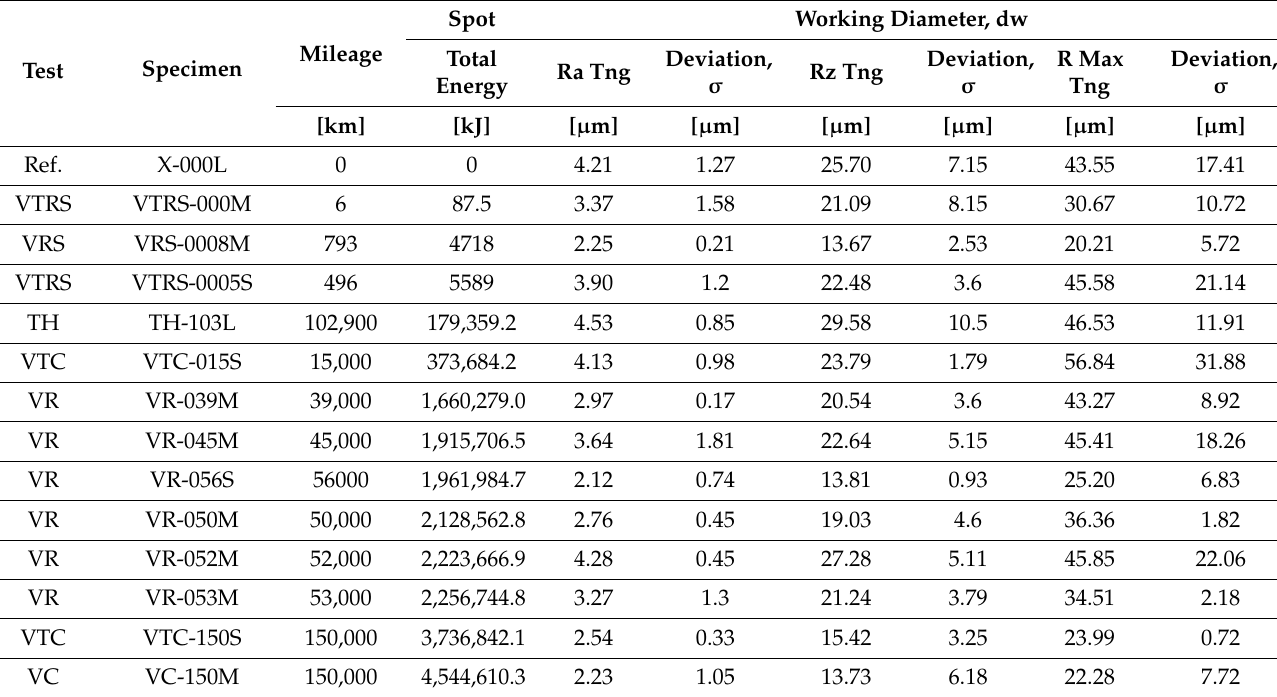
Table A5. Summary of the surface roughness values before (reference) and after different tests: outer diameter, tangential direction.